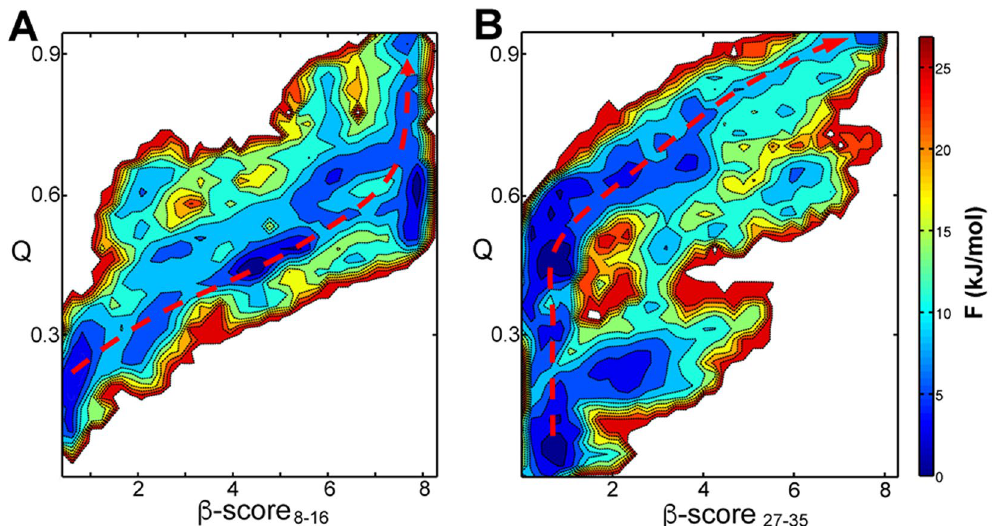
Figure 3. Two-dimensional free energy landscapes of hIAPP dimerization as a function of order parameters β -score β -score 8–16 and Q values ( A ) and 27–35 and Q value ( B ). The red dashed lines represent the lowest free energy pathways from the disordered structures to the fibril-like